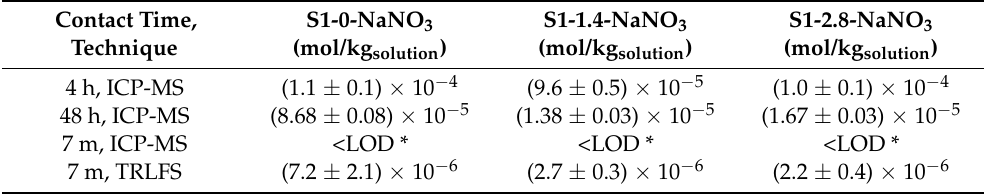
Table 2. U(VI) concentration measured in solution as a function of contact time and NaNO 3 content. Contact